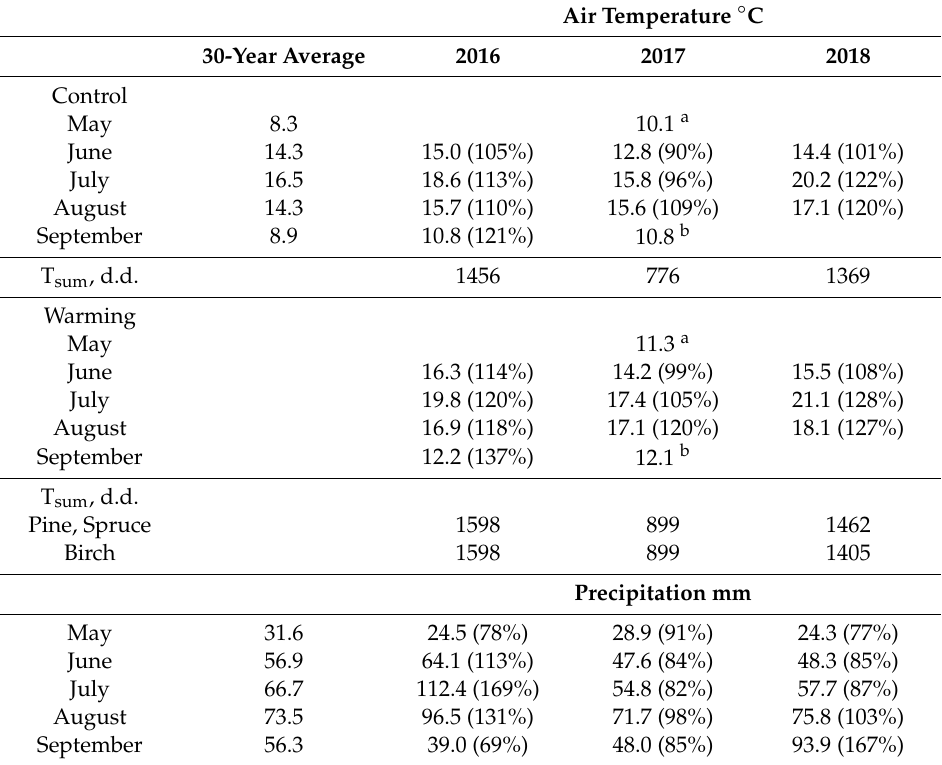
Table 1. Monthly averages ( ◦ C) for the air temperature on control (ambient temperature) and warming (simulated warming of + 1.3 ± 0.2 ◦ C) plots, monthly precipitation sum (mm), and temperature sum (T sum , degree days, d.d., with + 5 ◦ C threshold) for growing seasons of 2016–2018 in the experimental field, with corresponding 30-year averages (1981–2010) in Joensuu. Comparison to the 30-year averages as percentages are shown in parentheses. a Measured 18–31 May, b measured 1–6 September.